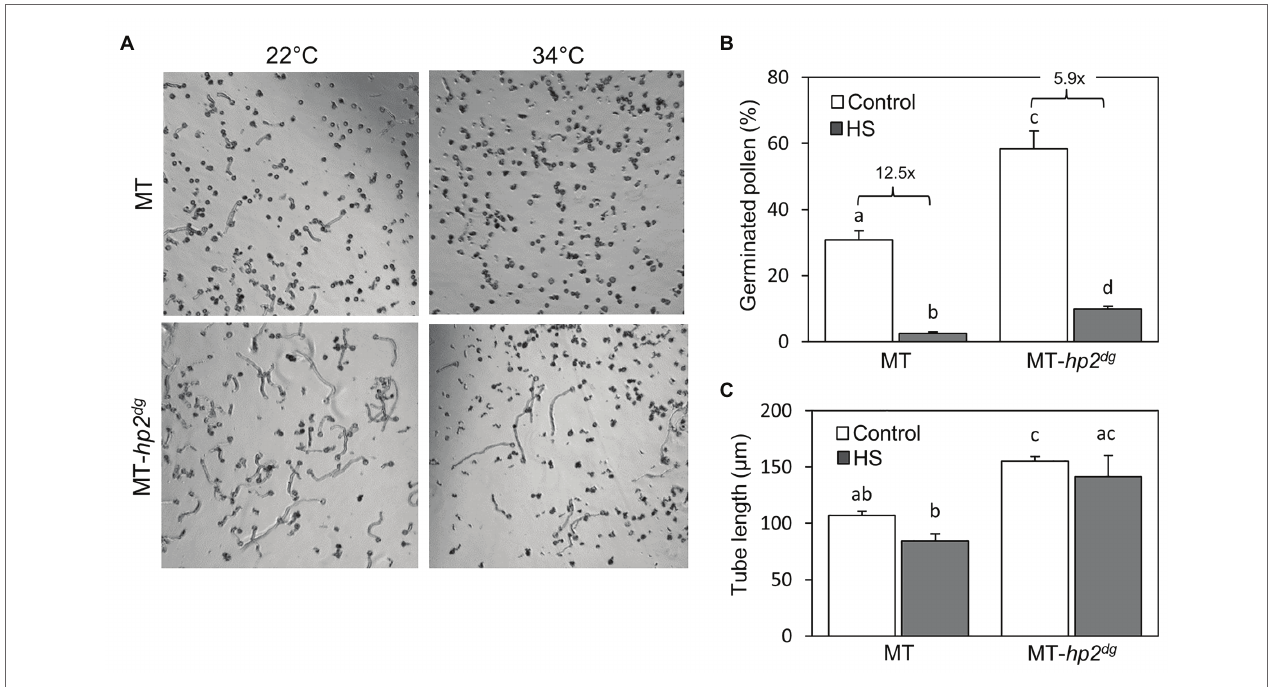
FIGURE 4 | The hp2 mutant shows better pollen germination following in vitro heat stress treatment. (A) Germinated pollen of hp2dg and MicroTom (MT) background following an in vitro heat stress treatment of 34 ° C for 30 min, compared with germination without heat stress (22 ° C). (B) Percentage of germinated pollen for hp2dg and MicroTom background following an in vitro heat stress treatment, compared with control conditions. Numbers denote fold change between control and heat stress samples in each genotype. (C) Pollen tube length of hp2dg and MicroTom pollen following an in vitro heat stress treatment, compared with control conditions. Error bars represent SEM, derived from three replicates. Different letters indicate statistically significant differences. HS, heat stress; MT,